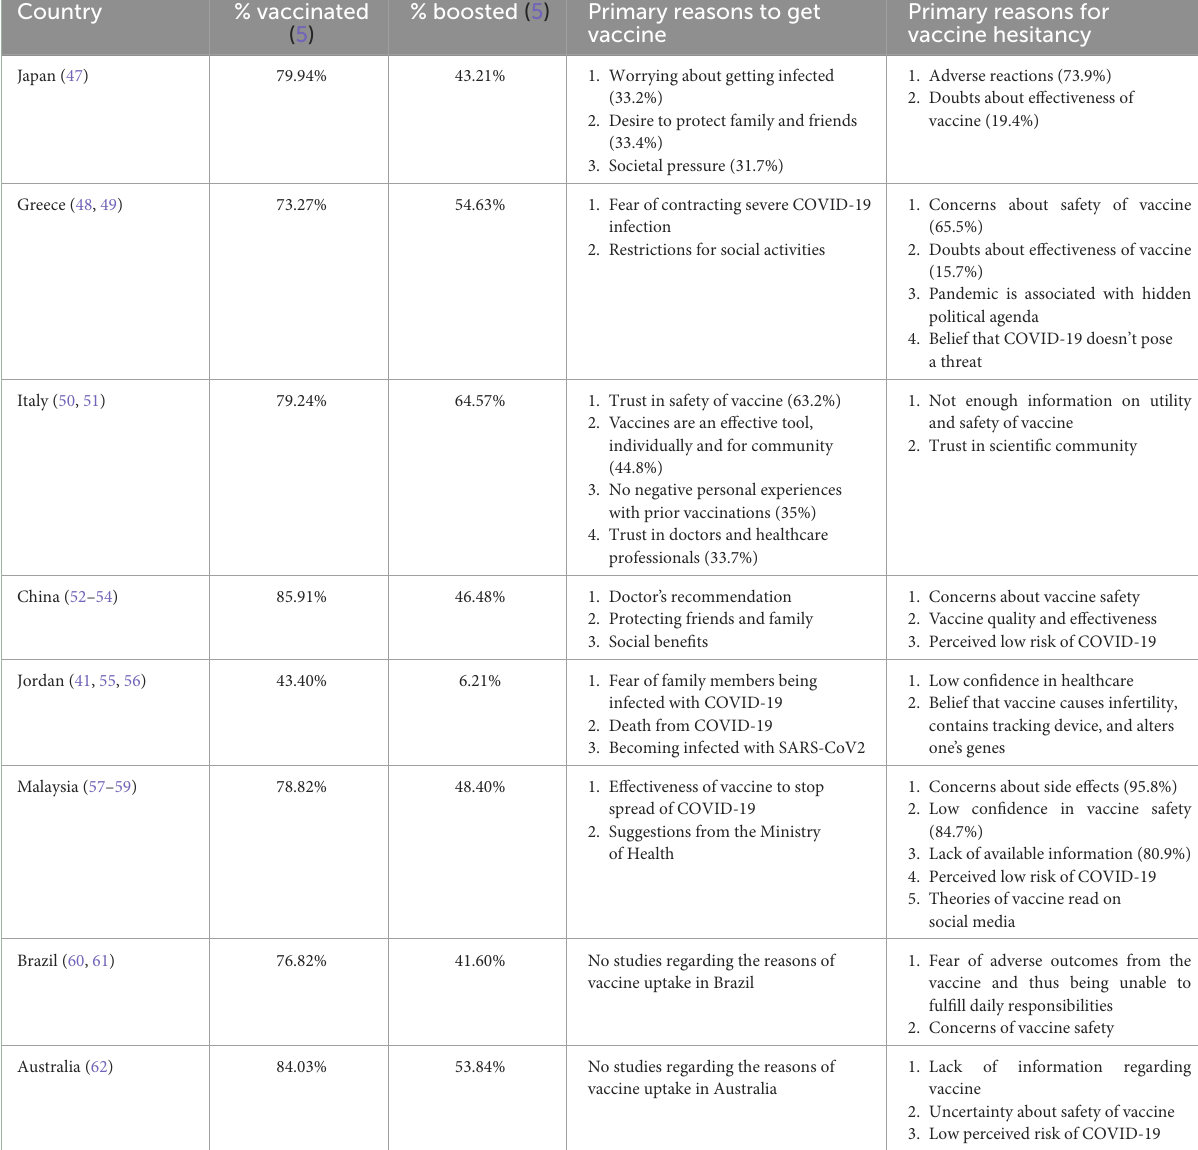
TABLE 1 A sample of different countries and the primary reason why citizens there choose to get vaccinated or not get vaccinated.